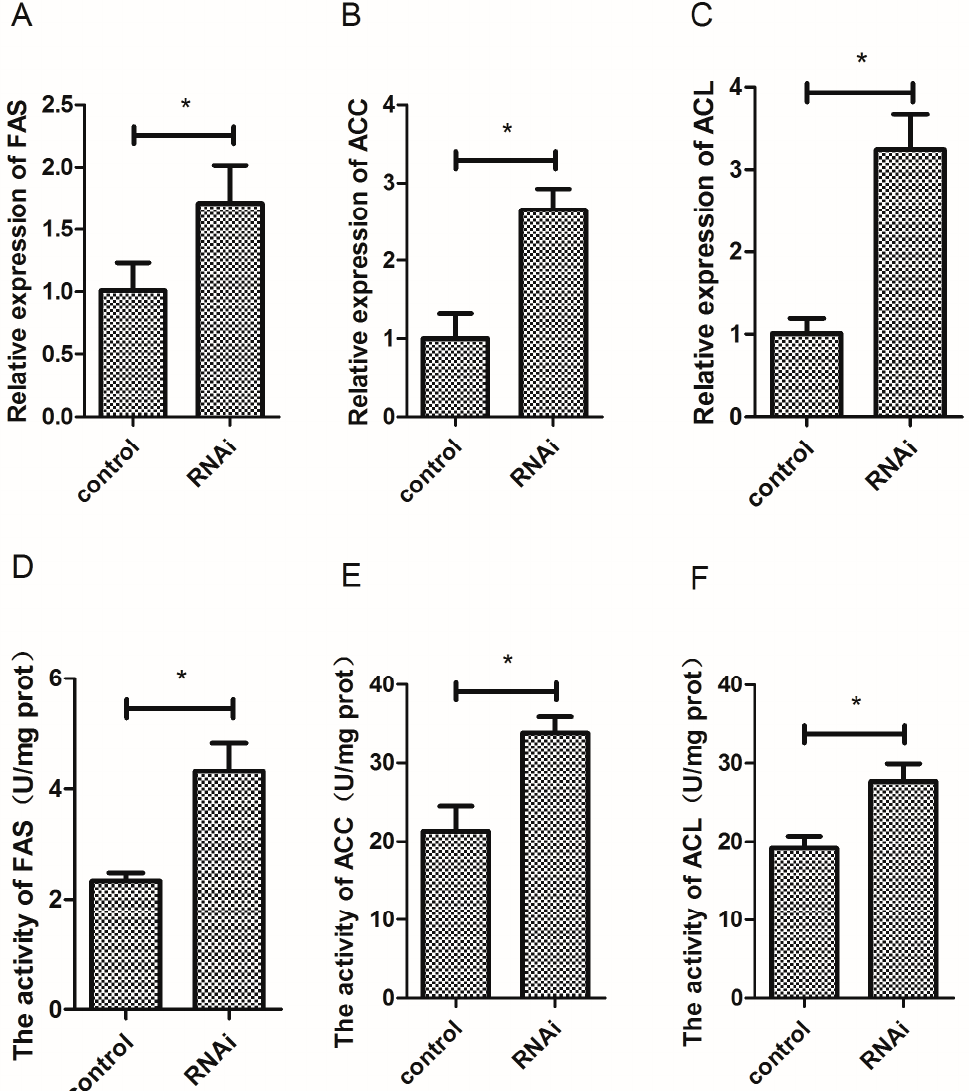
Figure 7. E ff ect of Wnt10b gene interference on the mRNA expression and activity of Fatty Acid Synthetase (FAS), Acetyl-CoA Carboxylase (ACC), and ATP-Citrate Lyase (ACL) in the muscle of zebrafish. ( A ) The mRNA expression of FAS; ( B ) The mRNA expression of ACC; ( C ) The mRNA expression of ACL; ( D ) The activity of FAS; ( E ) The activity of ACC; ( F ) The activity of ACL. Values are expressed as means ± s.e.m. ( n = 4). Statistically significant di ff erences are denoted by an asterisk (* p < 0.05).